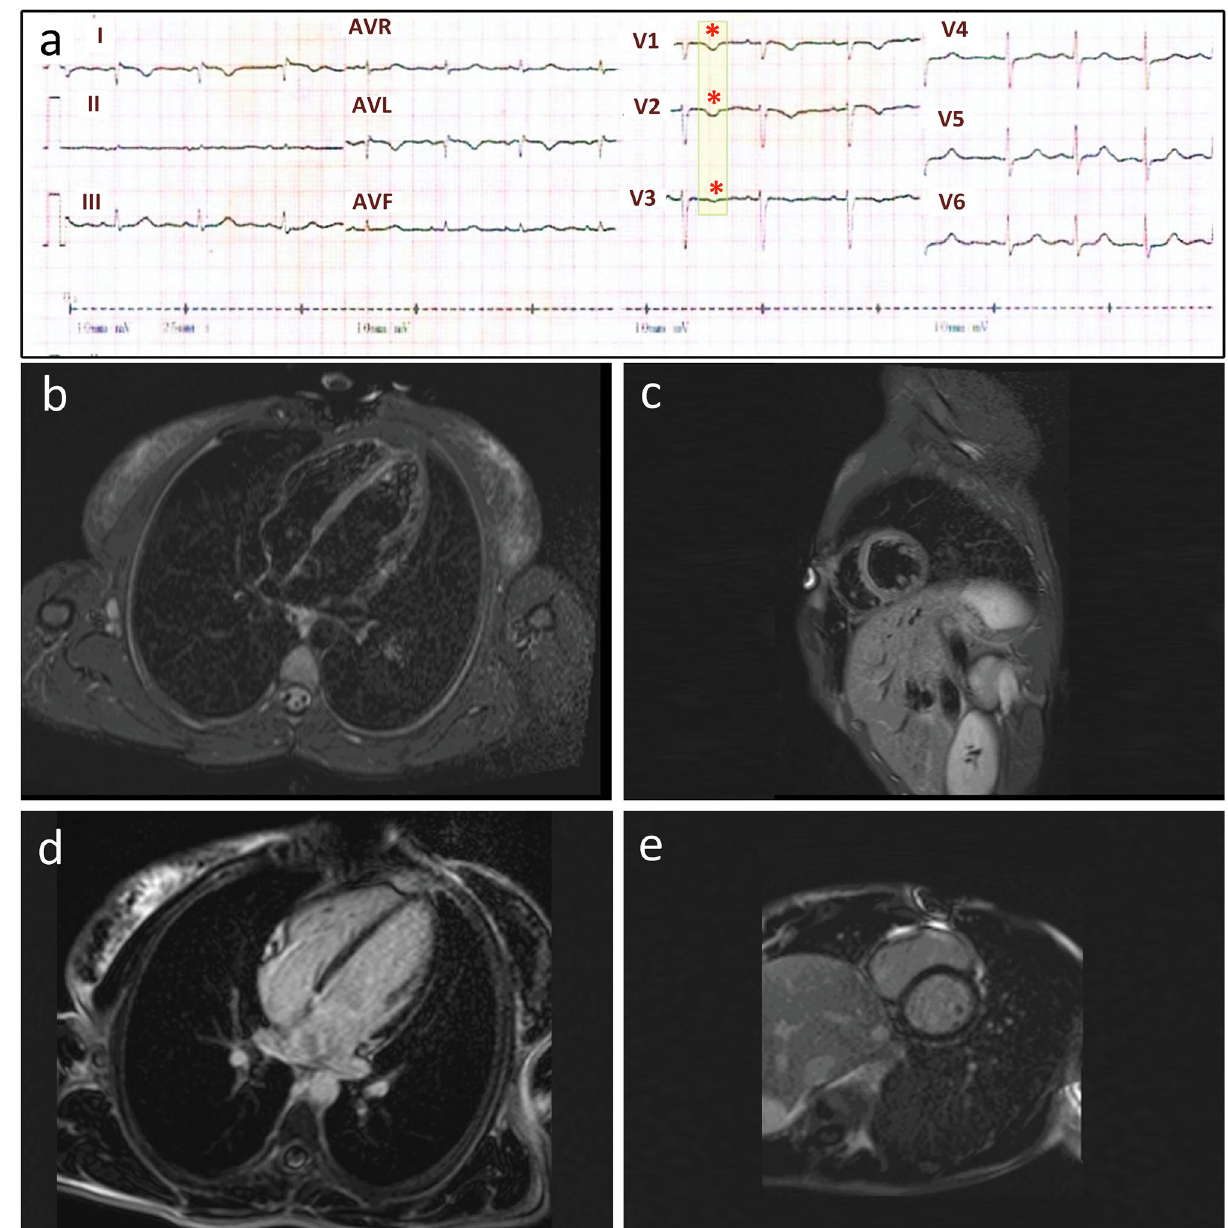
Figure 2. EKG, CMRI with Gadolinium findings in Patient 2. ( a ) EKG shows inverted T waves in leads V1, V2 and V3 (asterisks, major criterion) and a prolonged V3 terminal activation duration (TAD) = 80 ms (minor criterion). Epsilon waves are absent. (There is also a right arm/left arm limb lead reversal). CMRI shows normal myocardial thickness and wall motion along with normal left and right ventricular size, volume, and function ( b and c). T2-weighted images (short-TI inversion recovery sequence) in the four-chamber ( b ) and short- axis ( c ) views of the ventricles show neither myocardial edema nor inflammation ( d and e ). Four-chamber ( d ) and short-axis views ( e ) of the ventricles in late Gadolinium enhancement sequences show no myocardial enhancement or evidence of myocardial replacement with manifestations similar to Patient 1, including fragile skin; fissures at skin folds, periorificial areas, and the lateral canthus of the eyes; PPK; hyperkeratotic plaques and follicular hyperkeratosis on the knees and elbows; subungual hyperkeratosis; and nail dystrophy (Fig. 1). Alopecia, sparse curly eyebrows and eyelashes, short stature, low weight, and delay of puberty were also noted. Pruritus and skin fragility had lessened with advancing age. In the family, elective terminations of two subsequent pregnancies had been conducted. The EKG showed inverted T waves in right precordial leads (V1, V2, and V3) (Fig. 2a) and prolonged terminal activation duration in V1 (80 ms). A 24-h Holter monitoring showed no ventricular ectopy. Echocardiography revealed normal left ventricular ejection fraction (EF), but enlarged RV dimensions. The PLAX RVOT/BSA and